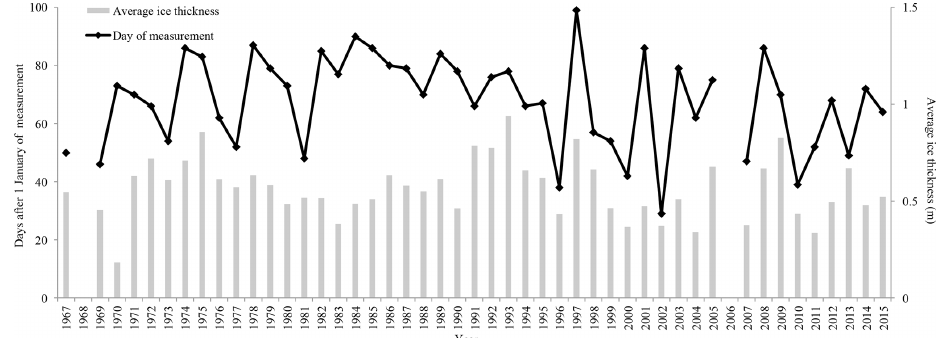
Figure 11. Plot showing average ice thickness (grey bars) day of measurement (black line) at site Nashwaak River below Durham Bridge (01AL002). Measurement dates input to CRID represent a range of 72d from 29 January (2002) to 9 April (1997). Initiation of break-up at this location ranges from 27 February (2010) to 13 April (2001) with the average being 25 March (84d after 1